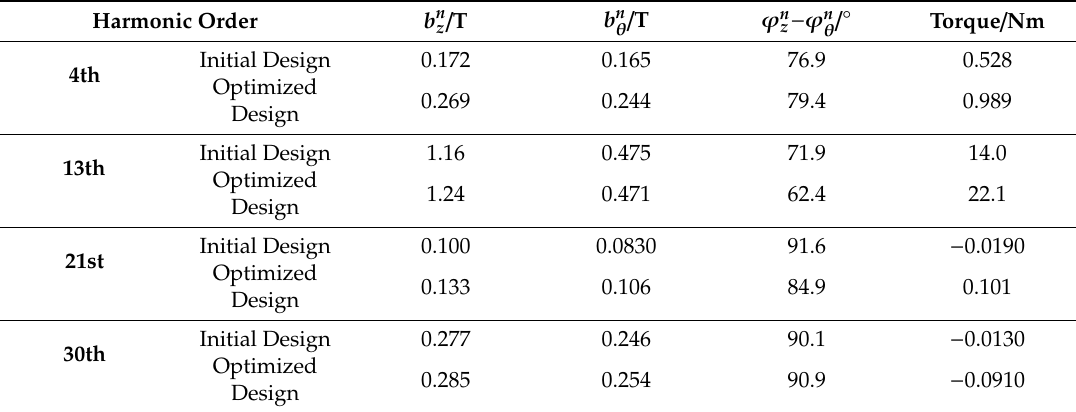
Table 10. Amplitudes, phase di ff erences and torque due to the air-gap flux density at the radius of R m4 .